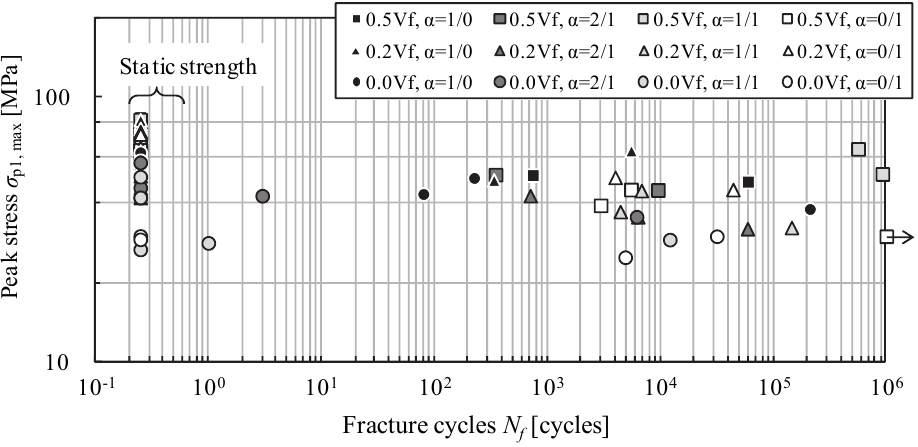
Figure 3: Relationships between σ p1, max and N f with various α in